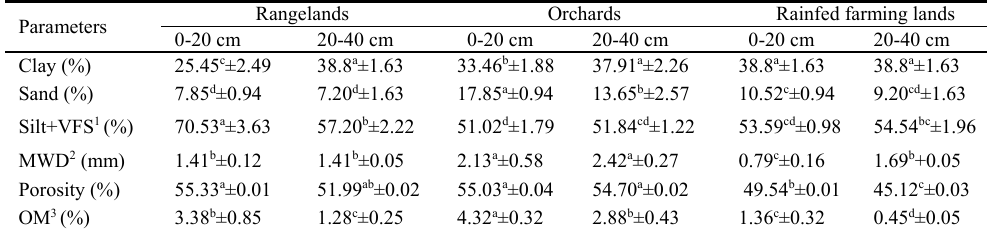
Table 2: Comparison of means for some soil properties in various land uses and depths (0-20 and 20-40 cm) Parameters